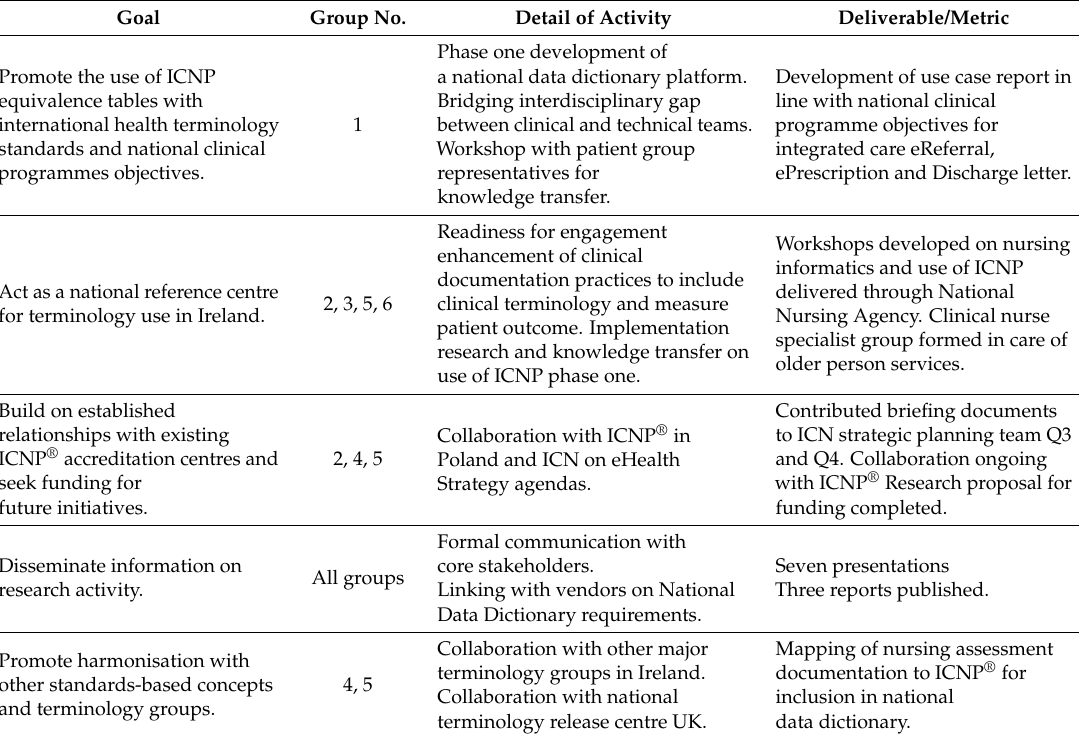
Table 1. Connecting relationship between the SNHS ICNP ® Centre goals and user group